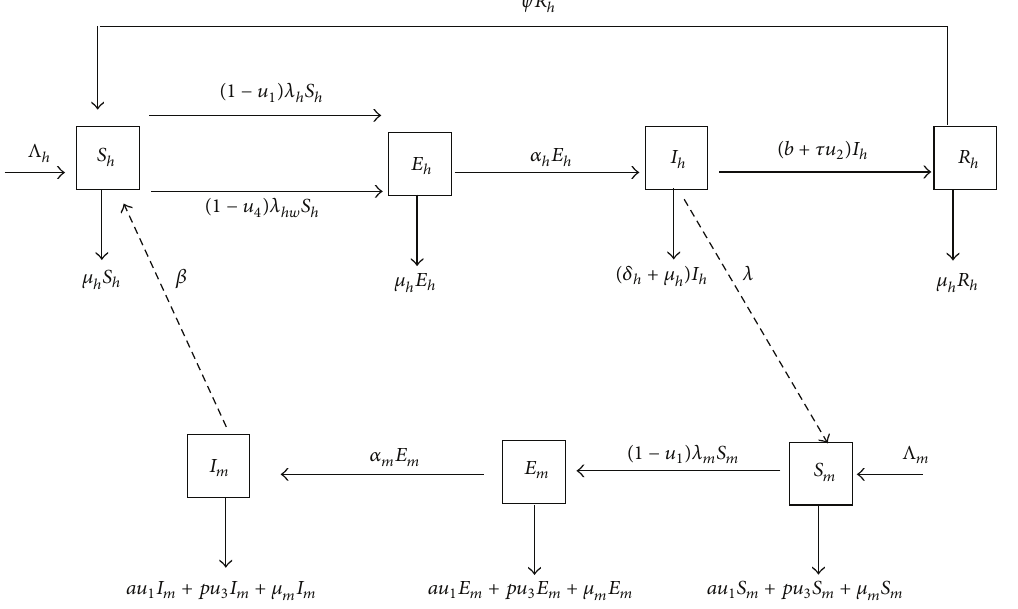
Figure 1: Malaria model with interventions.